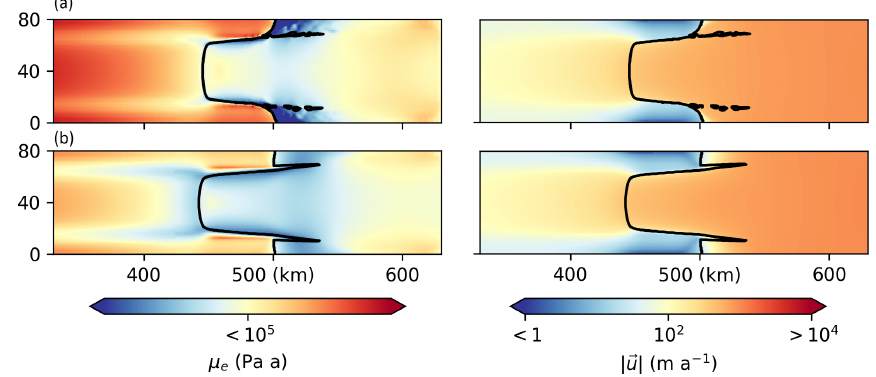
Figure 4. Comparison of the final IceD0 (a) and Ice0 (b) patterns of vertically averaged effective viscosity ( µ e ) and speed ( | u | ). The impact of damage on effective viscosity varies both laterally and between grounded and floating ice, but the shape and position of the grounding line (solid black contour) of IceD0 are similar to those of Ice0, as is the velocity field. These are approximately steady-state patterns as the grounded area and volumes change very little after 1000 years (see also Figs. 7 and 8).